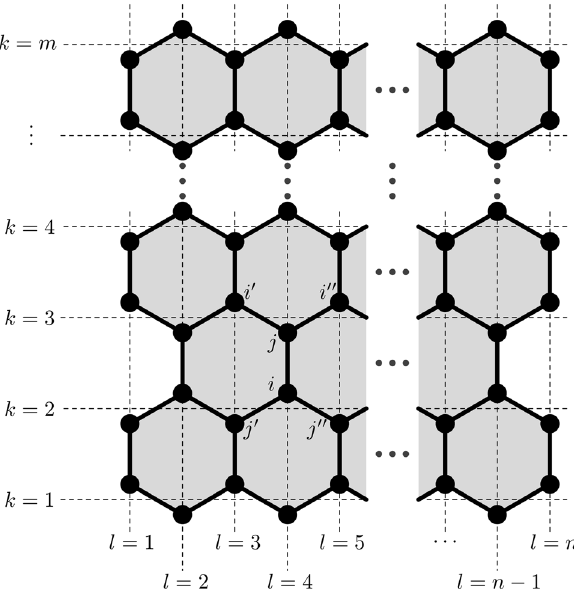
Figure 5. Schematic representation of indices in armchair graphene